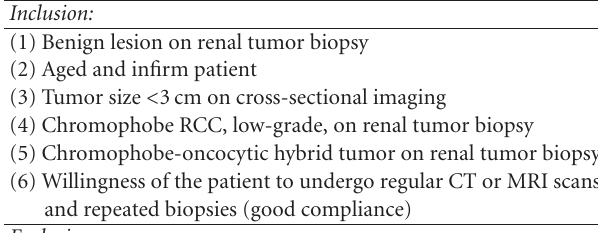
Table 1: Possible inclusion and exclusion criteria for active sur- veillance of